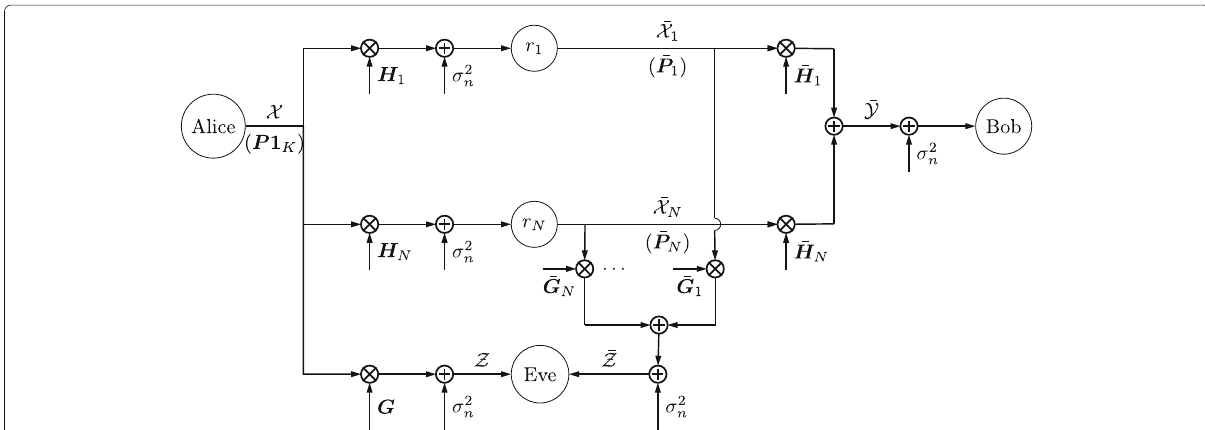
Fig. 1 System model of the relay parallel channels with N relays, r 1 , ... r N . Mixers ⊗ and adders (cid:3) represent element-wise multiplication and addition of vectors,